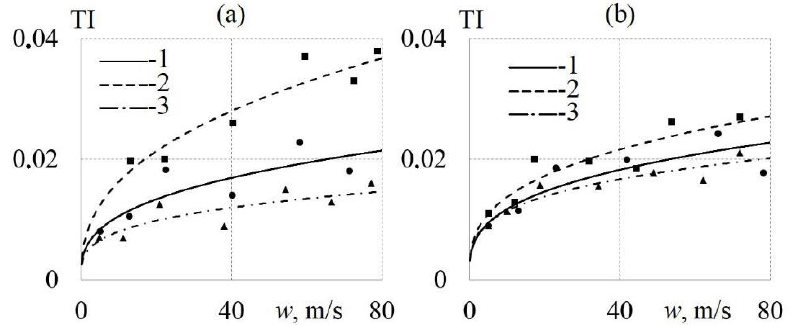
Figure 5. Dependences of turbulence intensity TI on average air velocity w in round (1), square (2), and triangular (3) pipes without a turbulator (average TI = 0.02) for control sections: ( а ) l x = 100 mm; ( b ) l x = 300 mm.